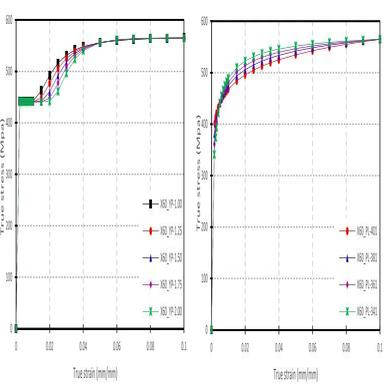
Idealized variations for stress-strain curves of X60-YPT and X60-RHT materials.